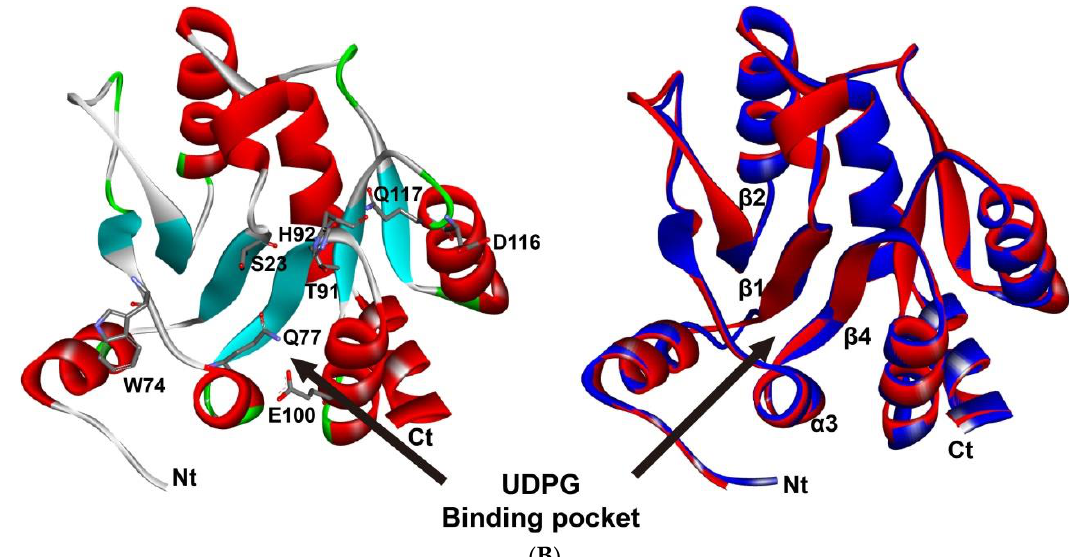
Figure 1. The UGT gene family in P. antennata . ( A ) Multiple alignments of amino acid sequences of 34 full-length PantUGTs. The signal peptides (orange), two donor binding regions (DBR1, cyan and DBR2, green), a transmembrane domain (magenta) and a cytoplasmic tail (blue) are indicated in colored boxes. Several key amino acids of DBRs involved in the sugar donor are shown by red numbers, including nucleotide interacting residues (1), phosphate interacting residues (2) and glucoside interacting residues (3). Two key catalytic residues (H and D) are labeled in red triangles. Other conserved amino acids with at least 30% identities in the sequences are shaded with a light-blue to dark-blue background. Based on the secondary structure of H. sapiens UGT2B7, α -helixes and β -sheets are indicated on the top of the alignment of PantUGTs. ( B ) The tertiary structure of PantUGT2 ( left ) and structural superimposition of PantUGT2 (red) and HsapUGT2B7 (blue) ( right ). Key residues (S23, W74, Q77, T91, H92, E100, D116 and Q117) and conserved regions (α 3, β 1, β 2 and β 4) are labeled on the structures. Arrows indicate the binding pockets of UDPG. Nt: N-terminus; Ct: C-terminus.